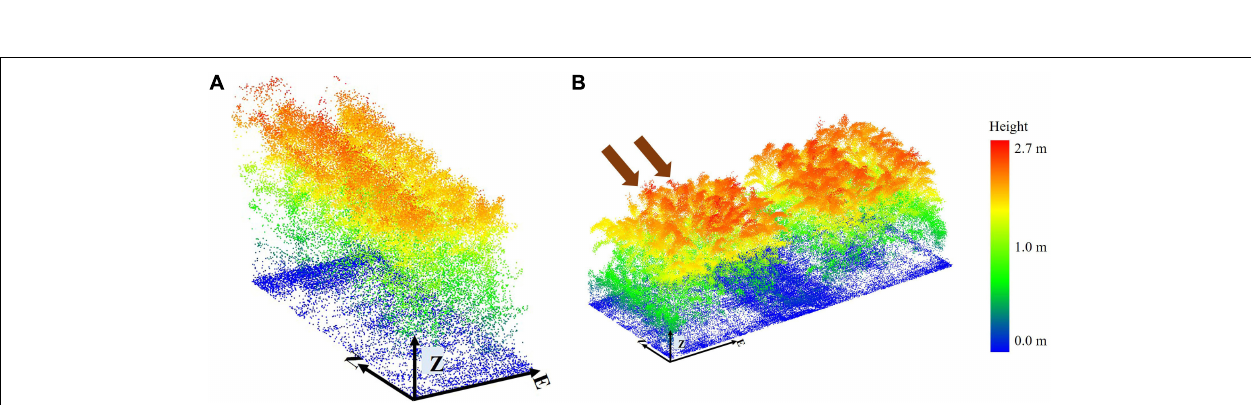
FIGURE 6 | Typical plot; (A) HIPS. (B) SbDivTc_Cal: rows 2 and 3 selected to extract features. The two arrows indicate rows 2 and 3. The orientation of the plot is shown with arrows (E: Easting, N: Northing, and Z: Elevation).